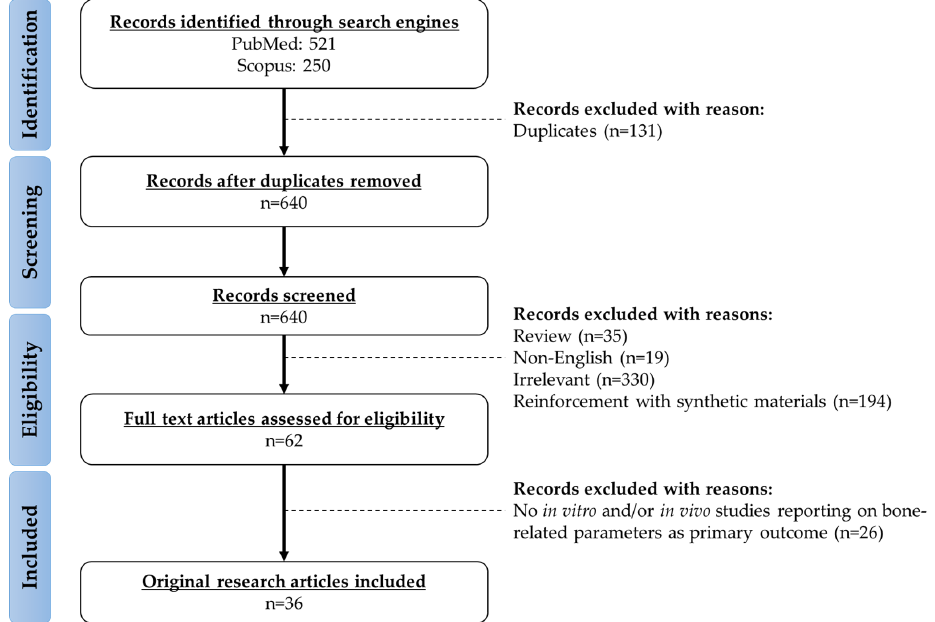
Figure 1. The framework for the selection of relevant